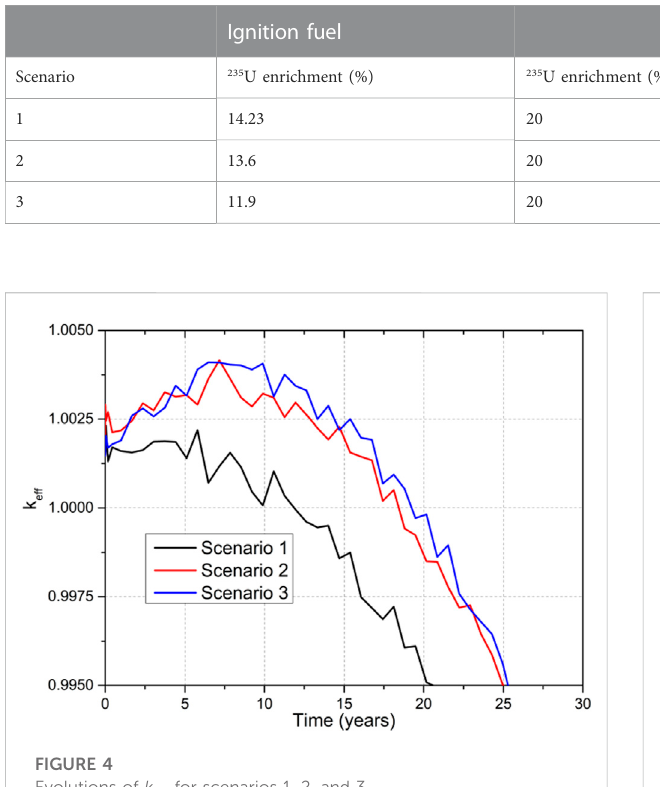
FIGURE 4 Evolutions of k eff for scenarios 1, 2, and 3.